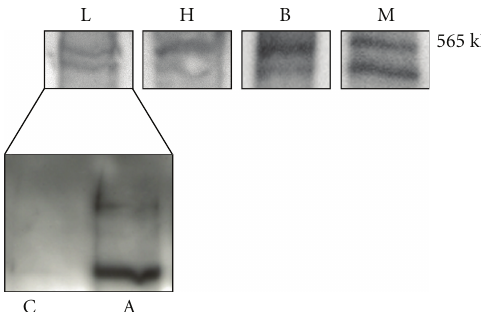
Figure 2: Ryanodine receptor alpha (RyR α ) and beta (RyR β ) pro- tein expression in homogenates of whole labyrinth (L), semicircular canal ampulla (A), semicircular canal arm (C), cardiac muscle (H), brain (B), and skeletal muscle (M). Lanes were loaded with 50 μ g of proteins, probed with a non-isoform-specific mouse monoclonal anti-ryanodine antibody (34C) diluted 1:800 and processed as described in Materials and Methods. Blots were acquired with the Image Master VDS (Amersham Biosciences Europe, Italy). All tissues (except for C) displayed two major bands corresponding to the alpha and beta isoforms, respectively. No bands were detected when anti-ryanodine antibody was omitted or substituted by nonimmune serum (not shown). Blots representative of four were shown.